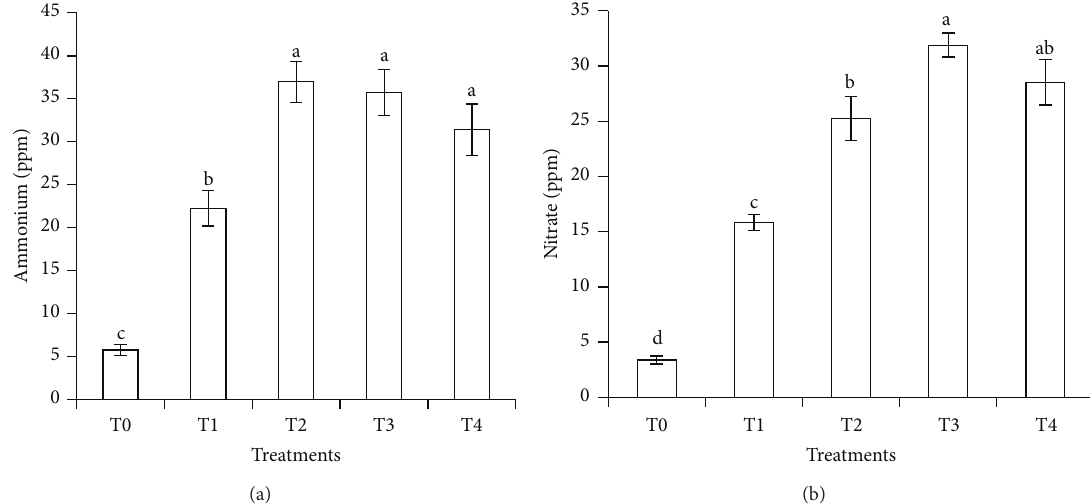
Figure 8: Retention of soil exchangeable ammonium and available nitrate after 30 days of leaching experiment. Note . T0: 64g soil (no urea); T1: 64g soil + 7.40g urea (no additives); T2: 64 g soil + 7.40g urea + 6 g clinoptilolite zeolite; T3: 64g soil + 7.40 g urea + 1.54 g compost; T4: 64g soil + 7.40g urea + 1.54 g compost + 6g clinoptilolite zeolite. Means with different letters indicate significant difference between treatments by Tukey’s test at 𝑃 ≤ 0.05 . Note . Bar represents standard error of the